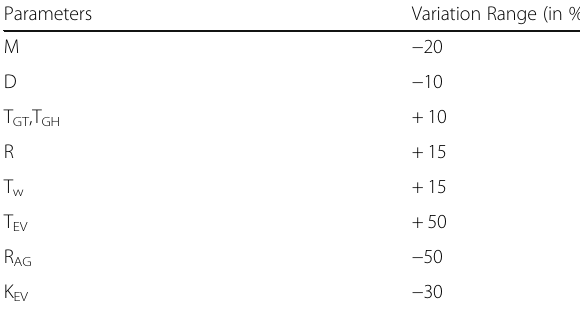
Table 4 Uncertain parameters of the test system and